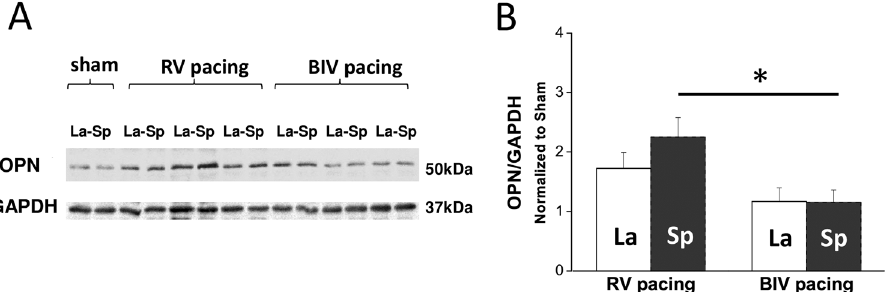
Figure 6. RV tachypacing induces global activation of osteopontin. Biochemical analysis of osteopontin (OPN) levels in rats subjected to either RV tachypacing or BiV tachypacing at a CL of 100 ms for 72 hours. La = lateral wall, Sp = septum. ( A ) Immunoblots demonstrating OPN and GAPDH (loading control). Cropped blots are shown. Uncropped blots are presented in Supplementary Fig. 5S. ( B ) Bar graph summarizing the densitometry results of 6 individual rats in each pacing mode. Note the marked increase of 50 kDa OPN in both septum and free wall of rats exposed to RV tachypacing. In comparison, BIV pacing demonstrated significantly reduced levels in the